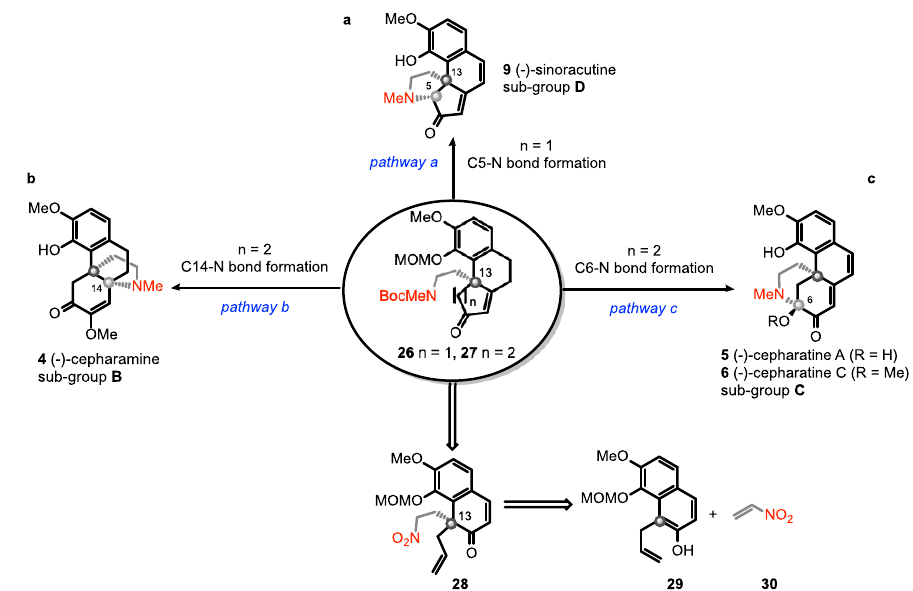
Fig. 2 Retro-synthetic analysis of hasubanan alkaloids: a uni fi ed synthetic route. a Pathway a: formation of C5-N bond for the synthesis of sinoracutine ( 9 ) of sub-group D ; b Pathway b: formation of C14-N bond for the synthesis of (-)-cepharamine ( 4 ) of sub-group B ; c Pathway c: formation of C6-N bond for the synthesis of (-)-cepharatines A ( 5 ) and C ( 6 ) of sub-group C .